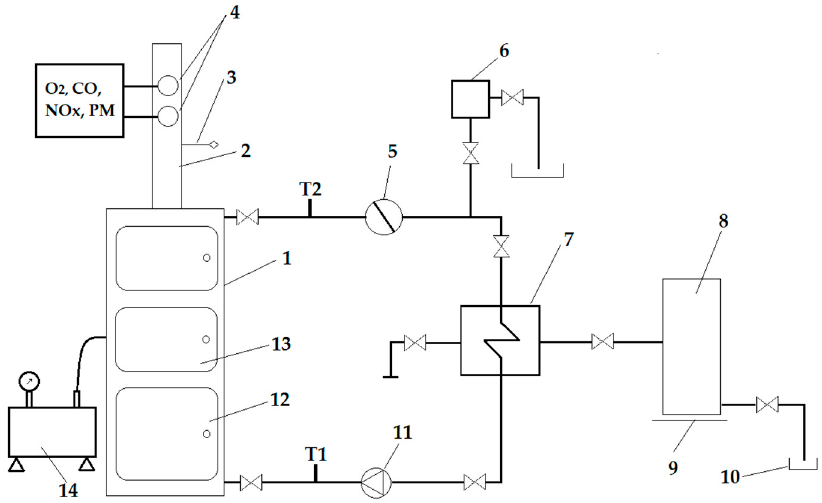
Figure 1. Scheme of test stand: 1—solid fuel heating boiler, 2—chimney, 3—measurement tem- perature, 4—measurement points of pollutants, 5—water flow meter, 6—expansion tank, 7—heat exchanger, 8—water tank, 9—weight scale, 10—outflow, 11—water pump, 12—combustion chamber, 13—steam–fed afterburning chamber, 14—water steam generator.